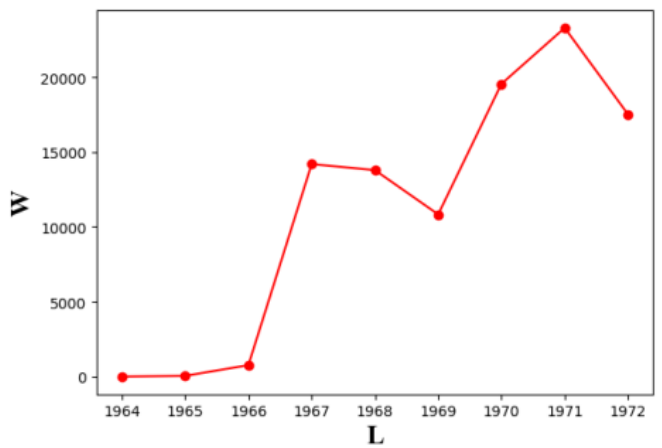
Figure 21. The influence of different placement sequences of heterogeneous transmitter on the length of heterogeneous line barrier (We use 6 types of transmitters, the number of 6 types of transmitters are { 3,2,5,3,4,3 } respectively, 20 transmitters in total, and test on 10,000 heterogeneous BR placement sequences).